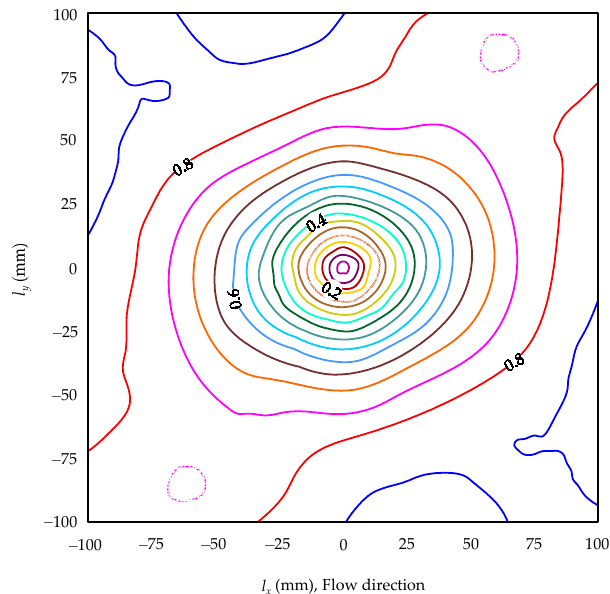
Figure 6. Contours of the second-order structure function for the roughness structure at a discharge of 0.25 m 3 s − 1 (data extracted from Aberle and Nikora [10]).